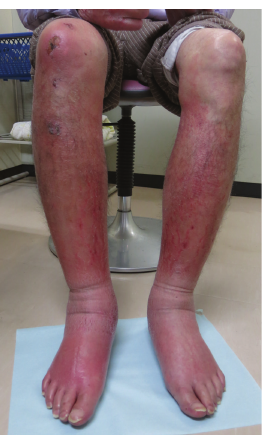
Figure 2: Prominent bilateral lower limb edema with asteatotic eczema.